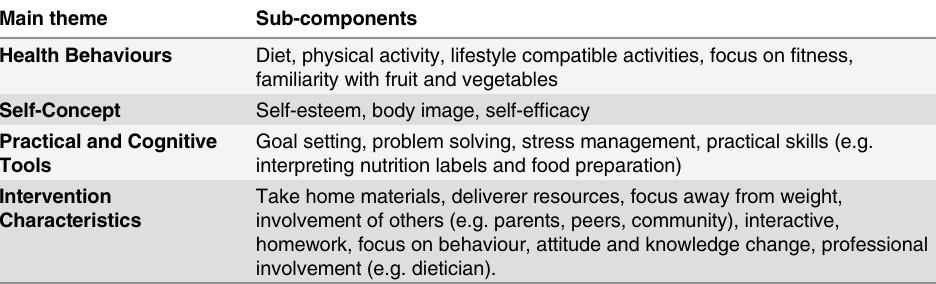
Table 2. Component